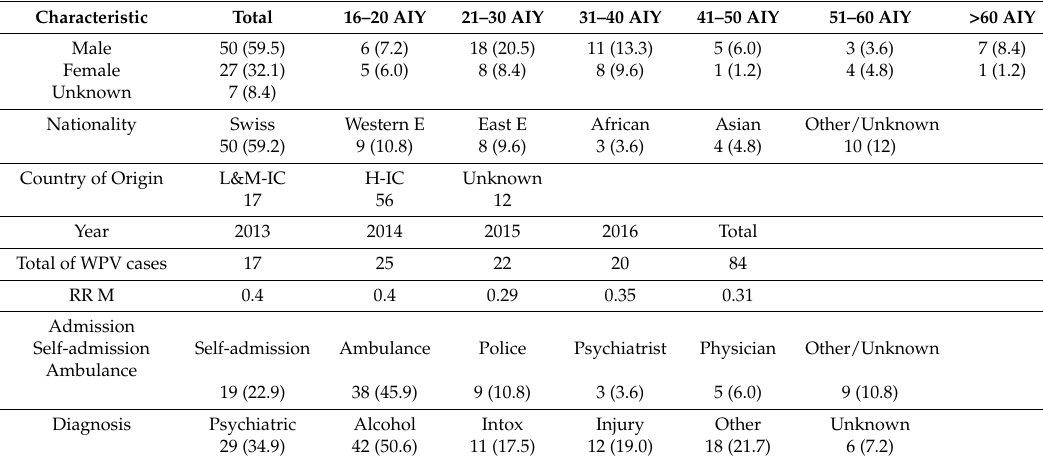
Table 1. Characteristics of the